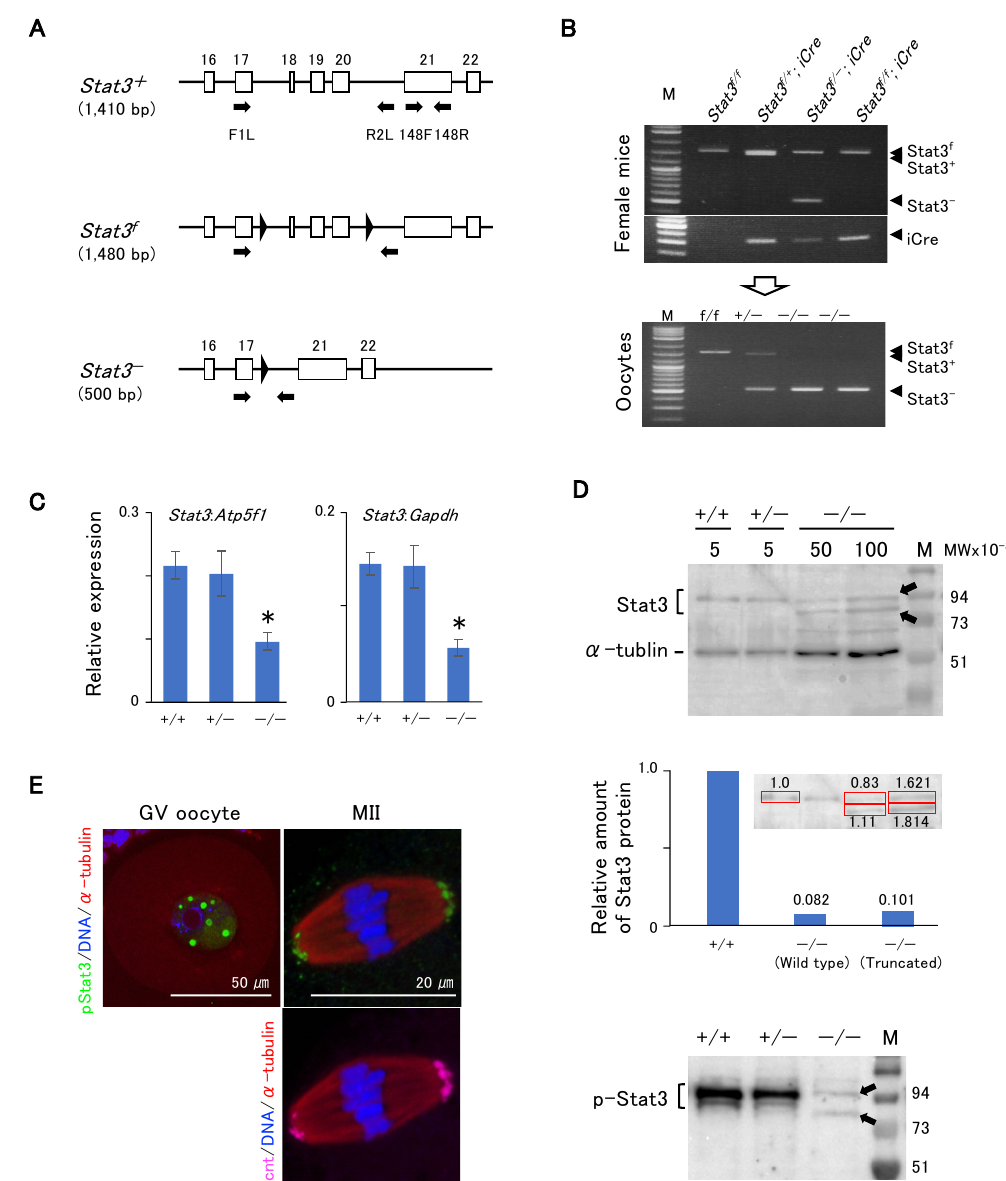
Figure 3. Phenotype of Stat3 − / − oocytes. ( A ) Schematic strategy of conditional knock out mouse [27] showing the positions of primers (arrows). Parentheses indicate the PCR product size for genotyping. ( B ) Genotyping PCR of oocytes with the primer set F1L / R2L. The Stat3 − / − oocytes (lower panel) were obtained from Stat3 f / f (f / − ) ; Gdf9-iCre female mice (upper panels). ( C ) RT-qPCR of oocytes with the primer set 148F / 148R. In the Stat3 − / − oocyte, the expression level of stat3 is approximately 40% that of the Stat3 +/+ oocyte. * P < 0.05. ( D ) Western blotting of oocytes. Arrows indicate the wild type (88 kDa) and truncated (77 kDa) Stat3 and pStat3. Both proteins were detected only in the Stat3 − / − oocytes. The middle panel shows quantification of the Western blotting signal for Stat3. The Stat3 +/+ oocyte (5 oocytes) was used as a reference. The amount of the Stat3 protein from 100 oocytes show approximately twice compared to that from 50 oocytes. Relative amounts of the Stat3 protein after calculation are shown, in which the total amount of Stat3 protein in the Stat3 − / − oocyte is approximately 18% of the Stat3 protein in the Stat3 +/+ oocyte. Numbers (5, 50, and 100) show the oocyte numbers loaded per lane. ( E ) Immunocytochemical analysis shows proper localization of the pStat3 in the Stat3 − / − oocyte. Note that the pStat3 signals (green) are weaker compared to those of the wild type shown in the Figure 2. Di ff erent colors indicate pStat3 (green), α -tublin (red), pericentrin (Pcnt) (magenta), and DNA